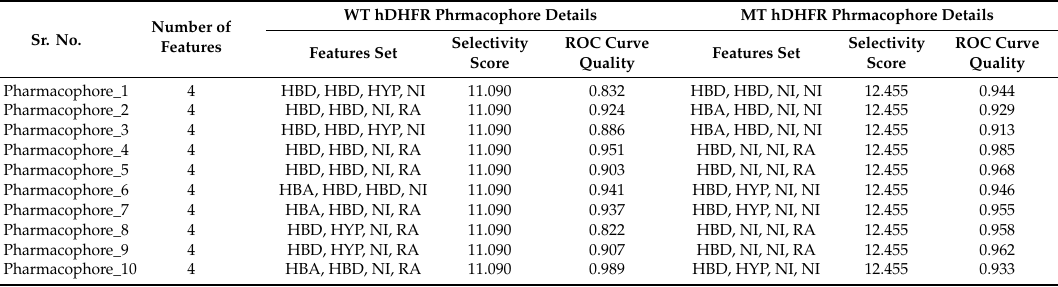
Table 1. Receptor-ligand based pharmacophores characteristics